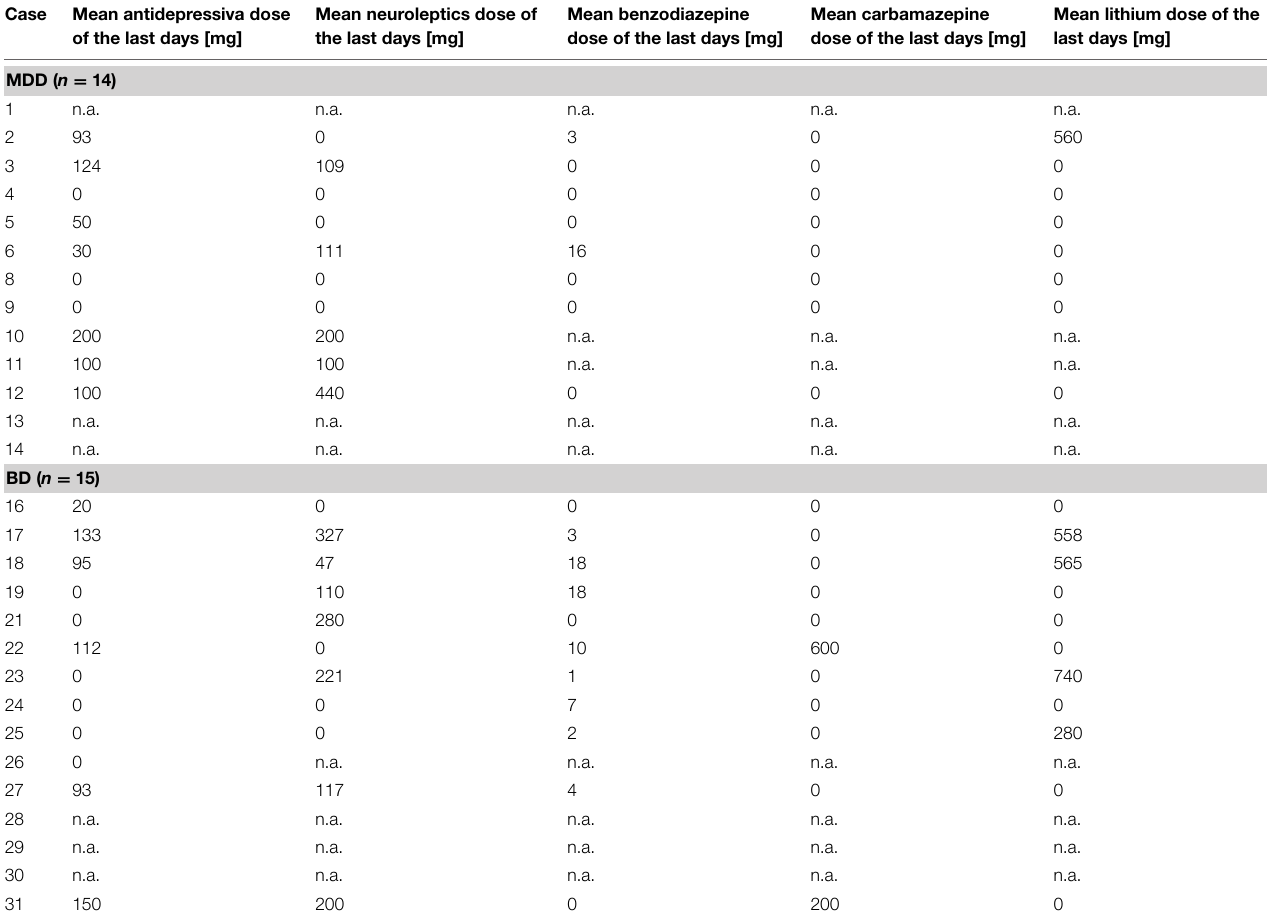
TABLE 2 | Psychopharmacological treatment. Case Mean antidepressiva dose of the last days [mg]